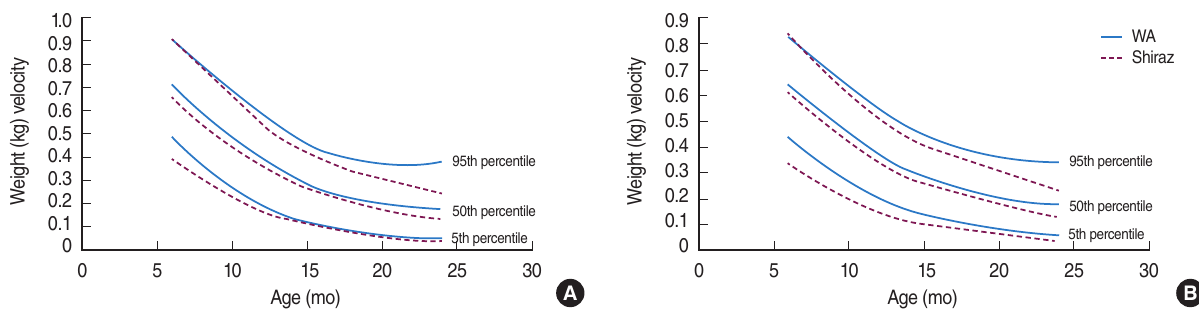
Figure 2. Weight (kg) velocity of infants in West Azerbaijan (WA) and Shiraz, Iran. (A) Males and (B)